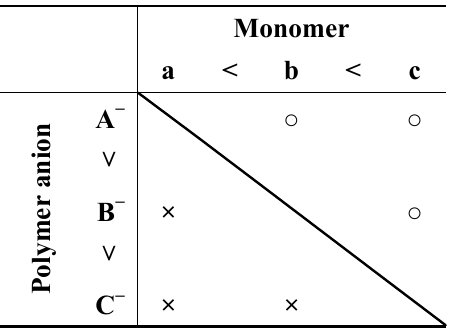
Table 1. Reactivity relationships among monomers and their chain-end anions.